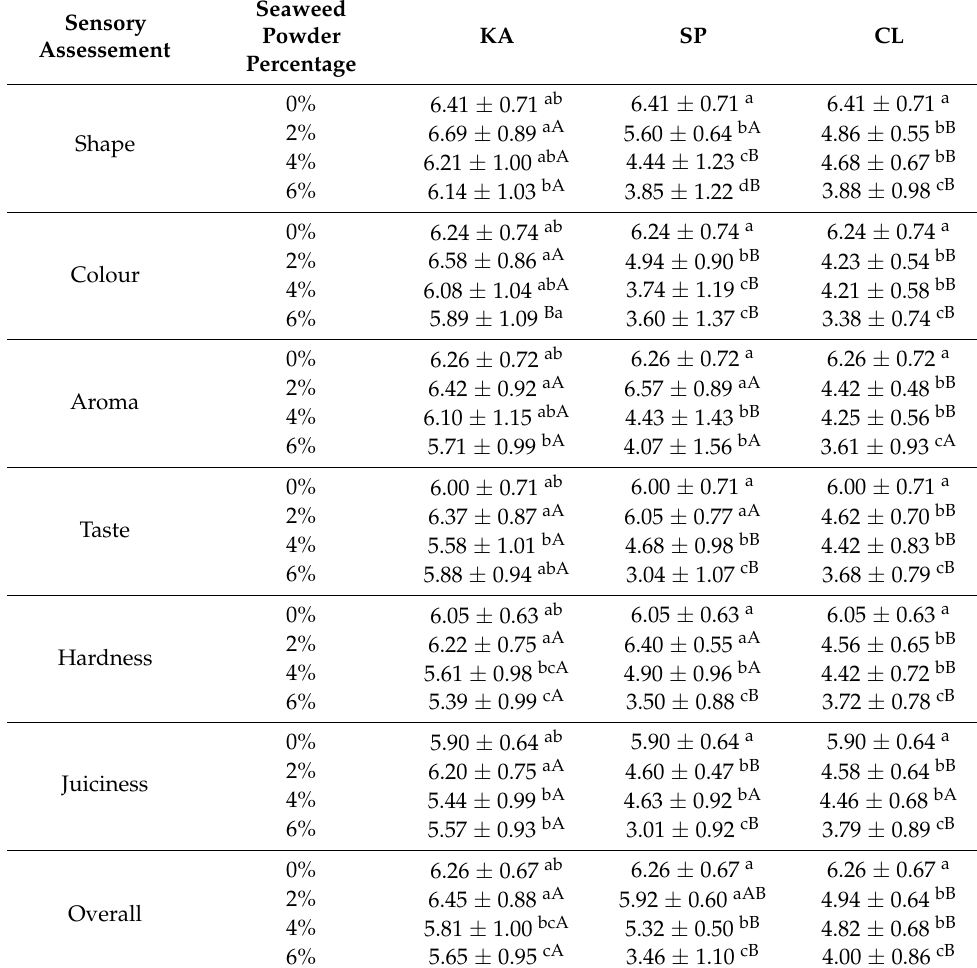
Table 6. The sensory assessment of chicken sausage with seaweed. Sensory